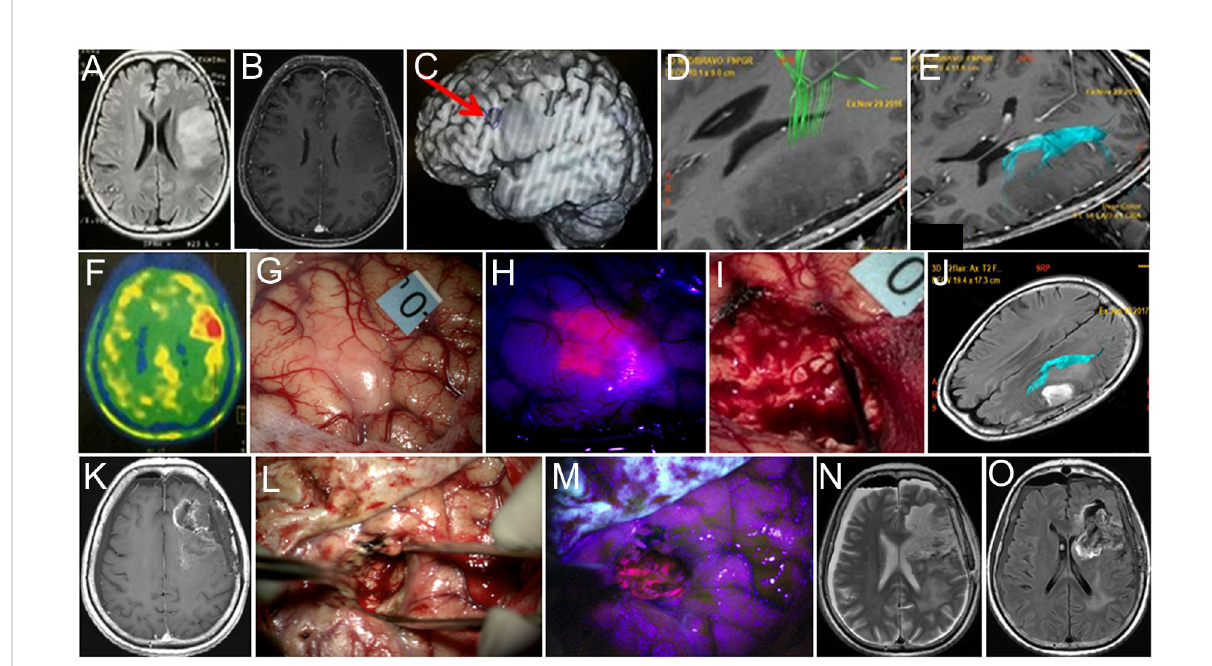
FIGURE 4 Case 4. A 60-year-old woman with left frontal diffuse astrocytoma that transformed into glioblastoma postoperatively. Preoperative axial Т 2 FLAIR (A) and contrast-enhanced T1 (B) MR images show non-enhancing mass. Broca ’ s area is indicated by the arrow on the functional MR image (C) . MR tractography demonstrates proximity of the pyramidal tract (D , green ) and the arcuate fasciculus (E , blue ) . PET with methionine shows increased drug accumulation (ratio = 1.3) in the tumor (F) . Intraoperative image shows right arm motor area labeled with 0 tag (G) . Blue400 mode demonstrates bright fl uorescence of the invaded cortex (H) . Resection was stopped due to speech alteration during bipolar and unipolar stimulation in the deep tumor cavity within the proximity of the AF leaving non fl uorescent tumor residual (I) . Postoperative axial Т 2- FLAIR MR image with arcuate fasciculus marked in blue demonstrates expected tumor residual (J) . Twelve-month follow-up contrast-enhanced T1 MR image demonstrates enhancing tumor focus (K) . Intraoperative images during the second surgery in white light (L) and Blue400 mode (M) demonstrate bright tumor fl uorescence. Postoperative axial T2-weighted (N) and contrast-enhanced T1 (O) MR images demonstrate gross total resection. Images (A – K) adapted from (21) courtesy of Goryaynov